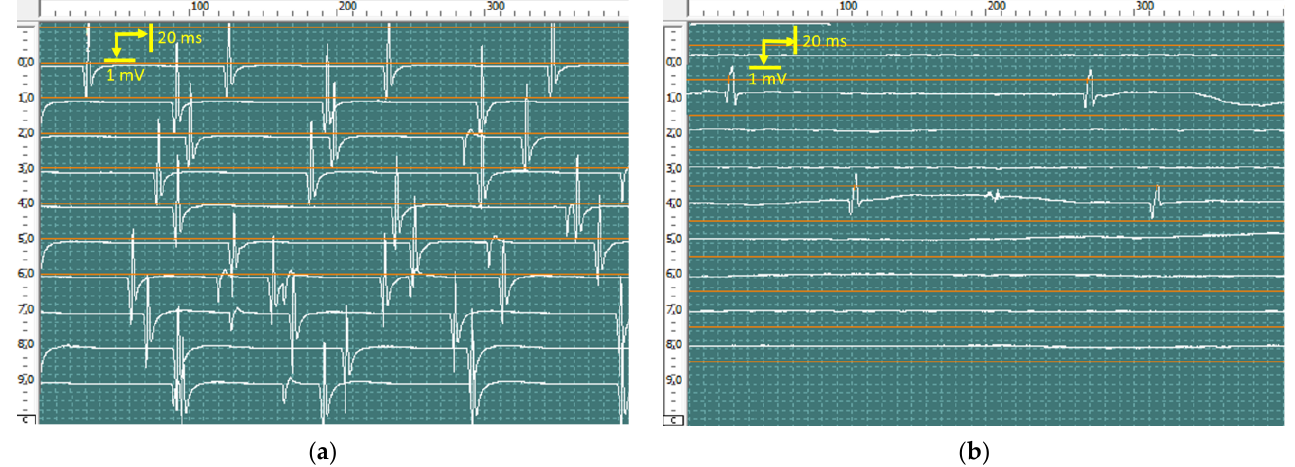
Figure 11. Recorded fasciculation potentials from the abductor digiti minimi of the left ( a ) and right ( b ) hands using concentric needles . The amplitude of fasciculation reached 6120 μV in the left hand and 1540 μV in the right hand.